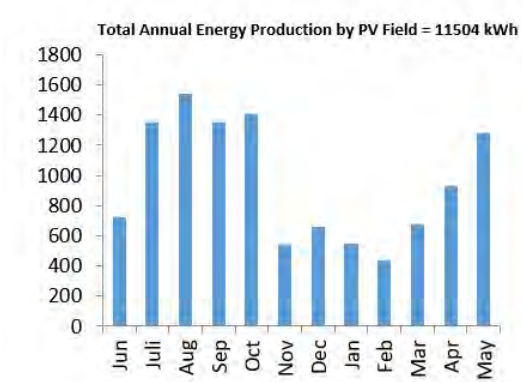
Figure 5. Monthly PV Energy production in kWh